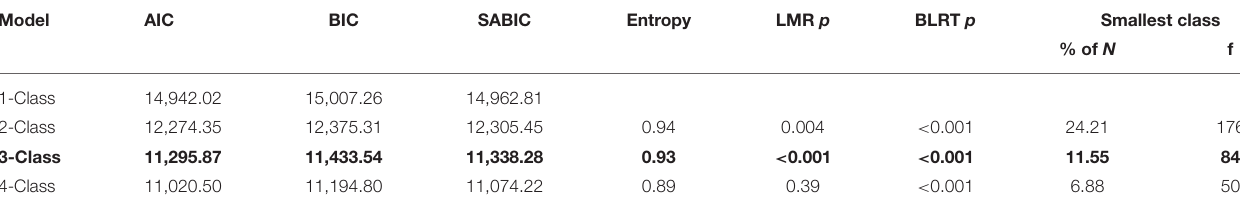
TABLE 3 | Summary of model selection indices of latent profile solutions for the total sample. Model